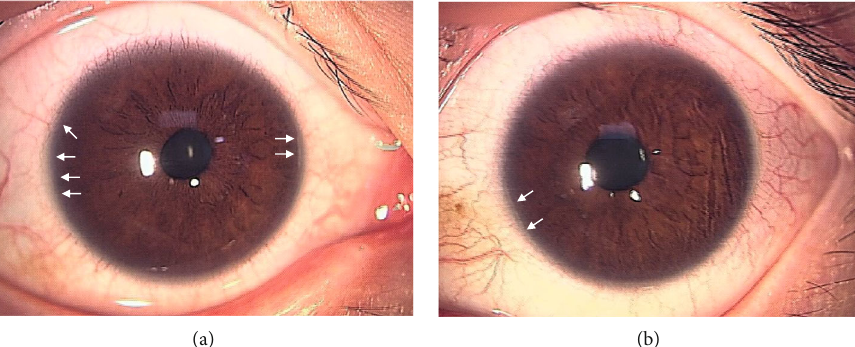
Figure 1: Slit-lamp photographs of the right (a) and left (b) eyes show posterior embryotoxon (arrows) and iris stromal atrophy.